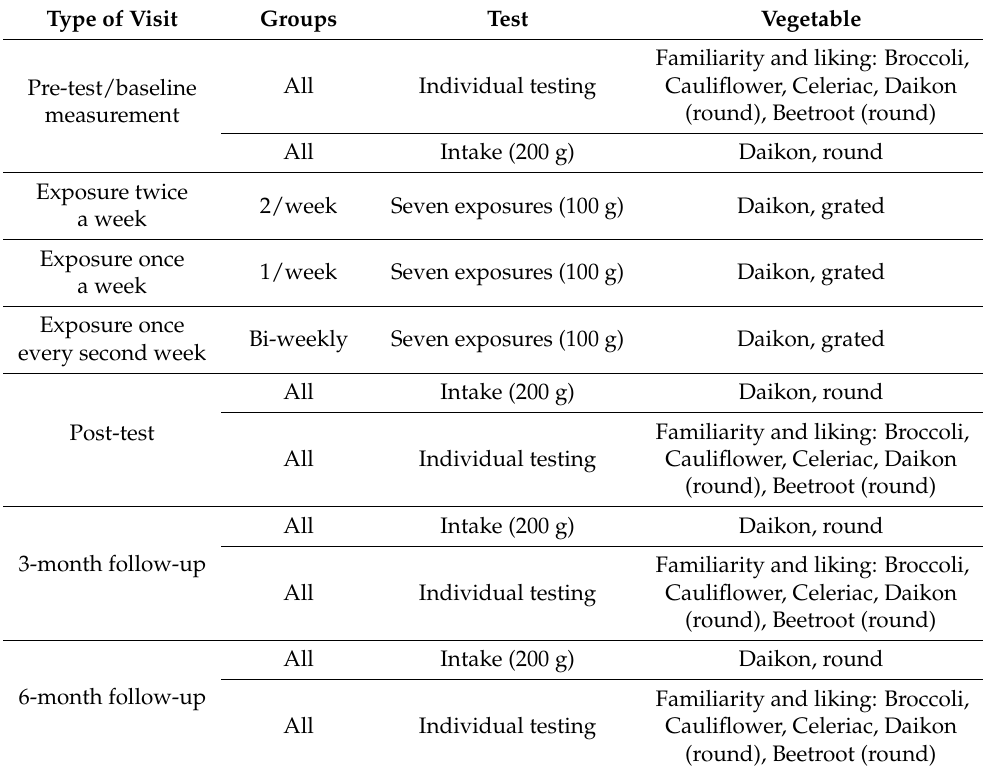
Table 1. Overview of the content of the different visit types.